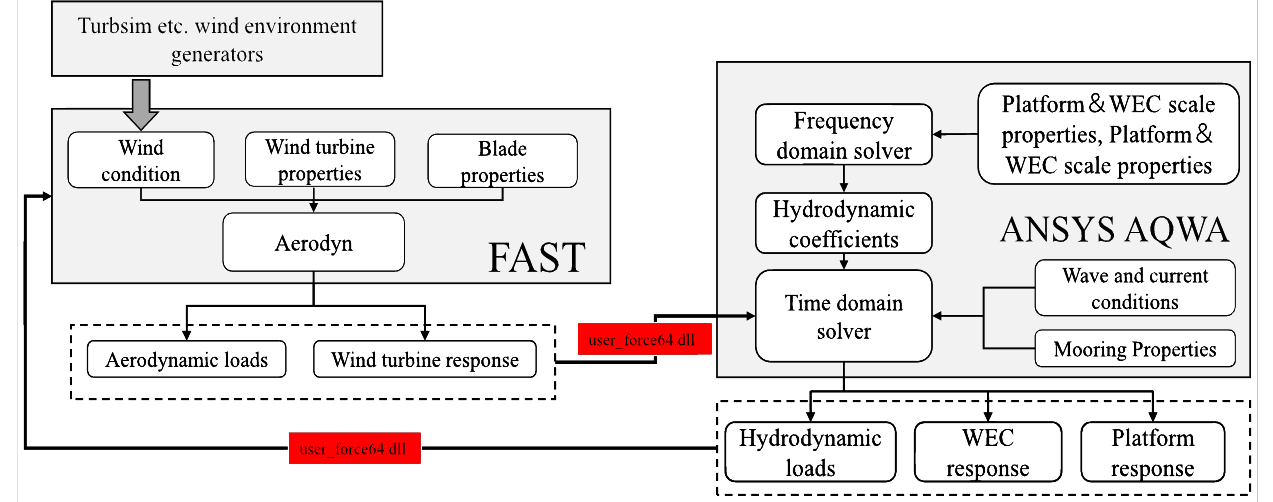
Figure 13. Schematic diagram of the fully coupled simulation process of F2A (FAST + ANSYS AQWA). with Frequency Domain Solution Results of Hydrodynamic Software Such as WAMIT, ANSYS AQWA, and